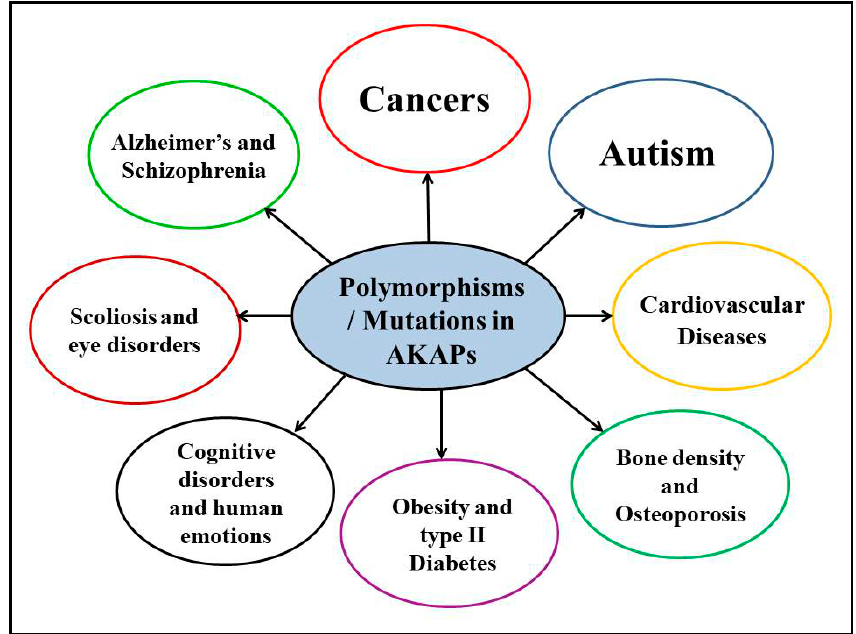
Figure 1. Genetics of AKAPs and human diseases.